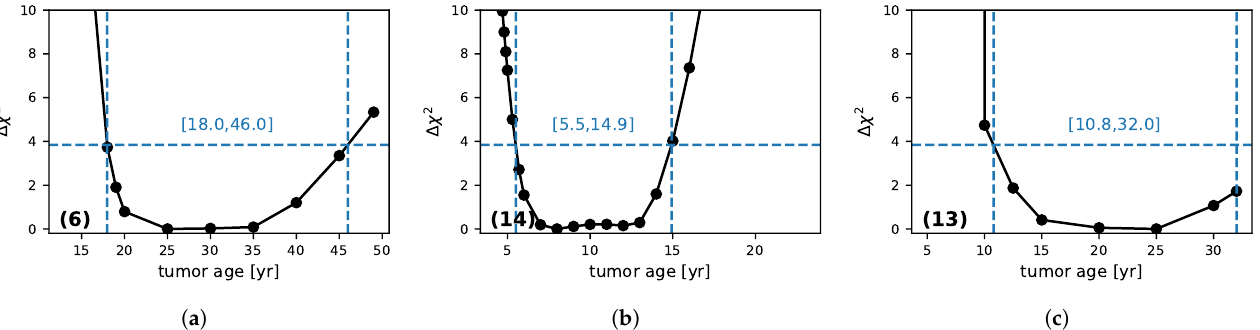
Figure 3. Constraints on the tumor age (at RT) with the profile-likelihood method. Results are shown for three patients ( a – c ) corresponding respectively to the data labelled (6), (14) and (13) on Fig.2. Considering the region below ∆ χ 2 < 3.84 (the horizontal dashed line), one can reconstruct a 95% confidence level interval (shown by the dashed vertical lines and corresponding range values). The last value of the abscissa is the patient